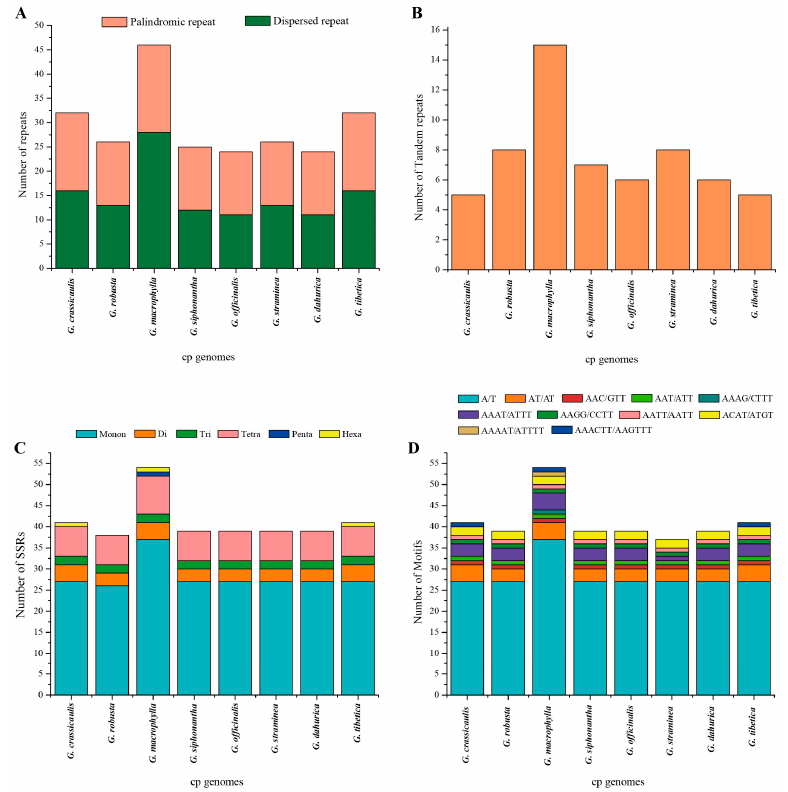
Figure 3. Analysis of different repeats in eight chloroplast genomes of Gentiana sect. Cruciata . ( A ) Histogram showing the number of palindromic repeats and dispersed repeats; ( B ) histogram showing the number of tandem repeats; ( C ) number of different simple sequence repeat (SSR) types